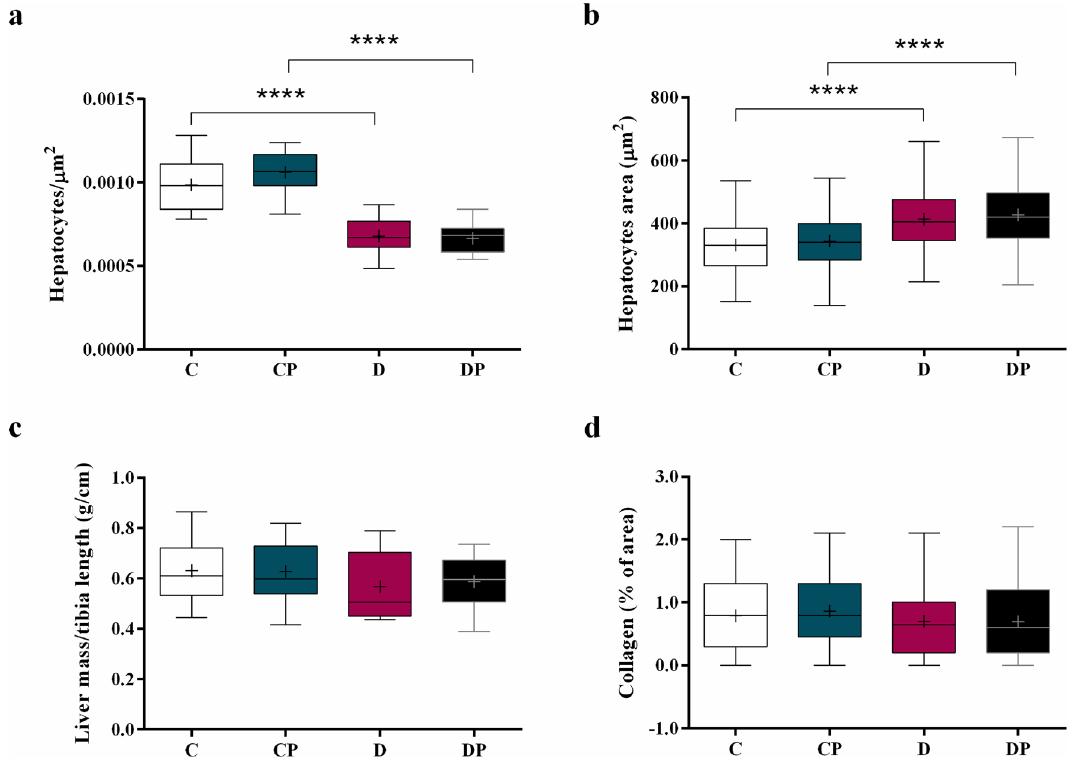
Figure 2. (a) Number of hepatocytes per µm 2 (b) hepatocytes area in µm 2 , (c) liver mass corrected by tibia length (g/cm), (d) collagen content (%) analyzed using CellProfiler 3.1.5 in control (C), control + probiotic (CP), diabetic (D) and diabetic + probiotic (DP) groups (n = 6–9/group). Data are from C57BL/6 STZ-induced diabetic mice, + /− Saccharomyces boulardii (0.5 × 10 8 colony-forming units, THT 500,101 strain , Probiotics and Starters Cultures, Belgium) for 8 weeks. A horizontal line inside the box indicates the median value of the samples within each group, and the upper and lower edges of the box indicate the quartiles. For (b,d) significance was determined by Kruskal–Wallis followed by Dunn’s test, and for (a,c) significance was determined by Two-way ANOVA followed by Tukey test for multiple comparisons of means (GraphPad Prism 6). + indicates mean value. **** p ≤